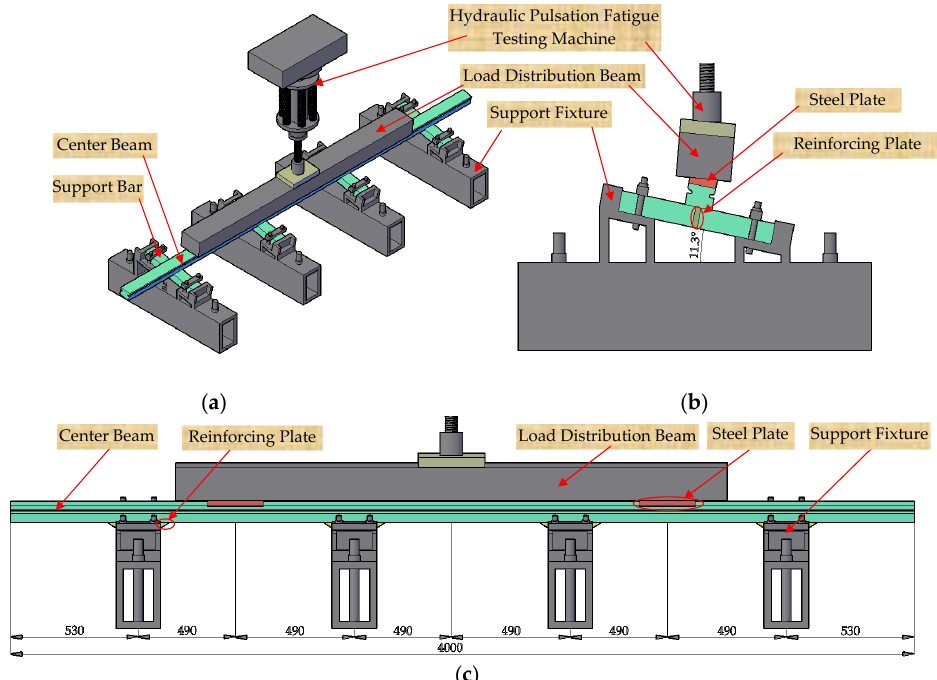
Figure 6. Loading configuration of the test specimen (unit: mm). ( a ) Three-dimensional view. ( b ) Left view. ( c ) Front view.